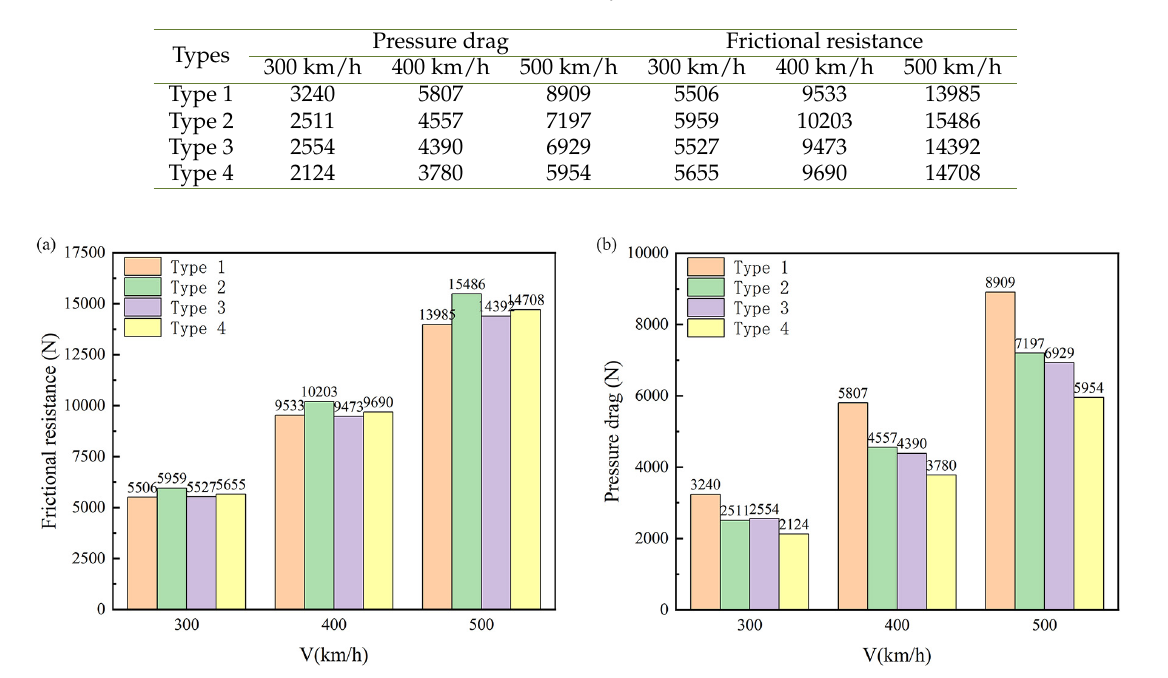
Table 2. Windscreen aerodynamic resistance (N).